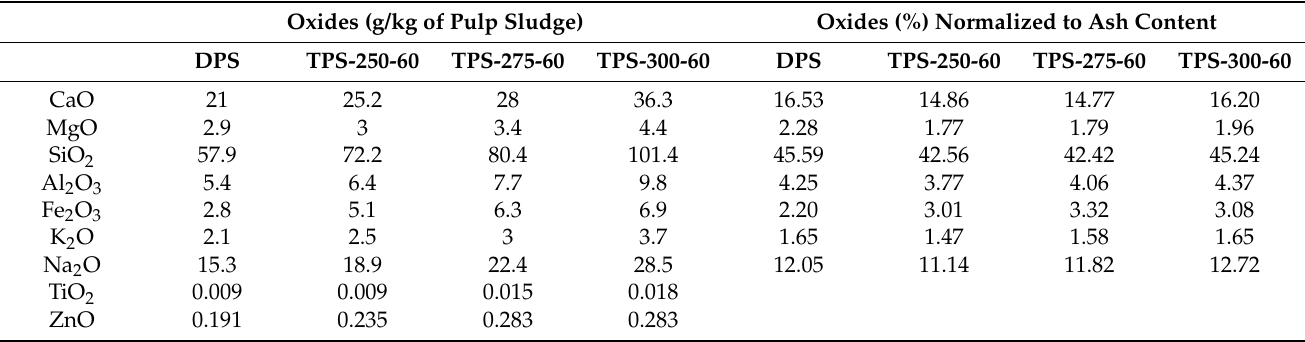
Table 4. Ash composition of dried and torrefied pulp industry